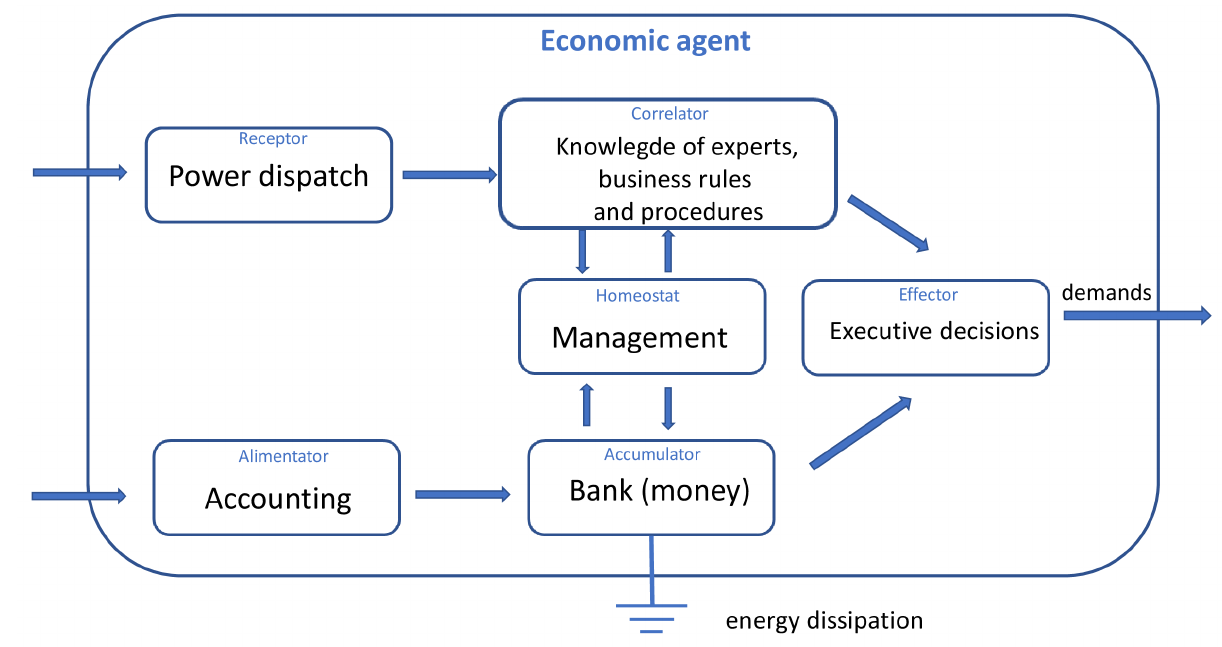
Figure 4. The power plant—the economic agent in the framework of Mazur’s theory. The organization of the agent is common for all types of power